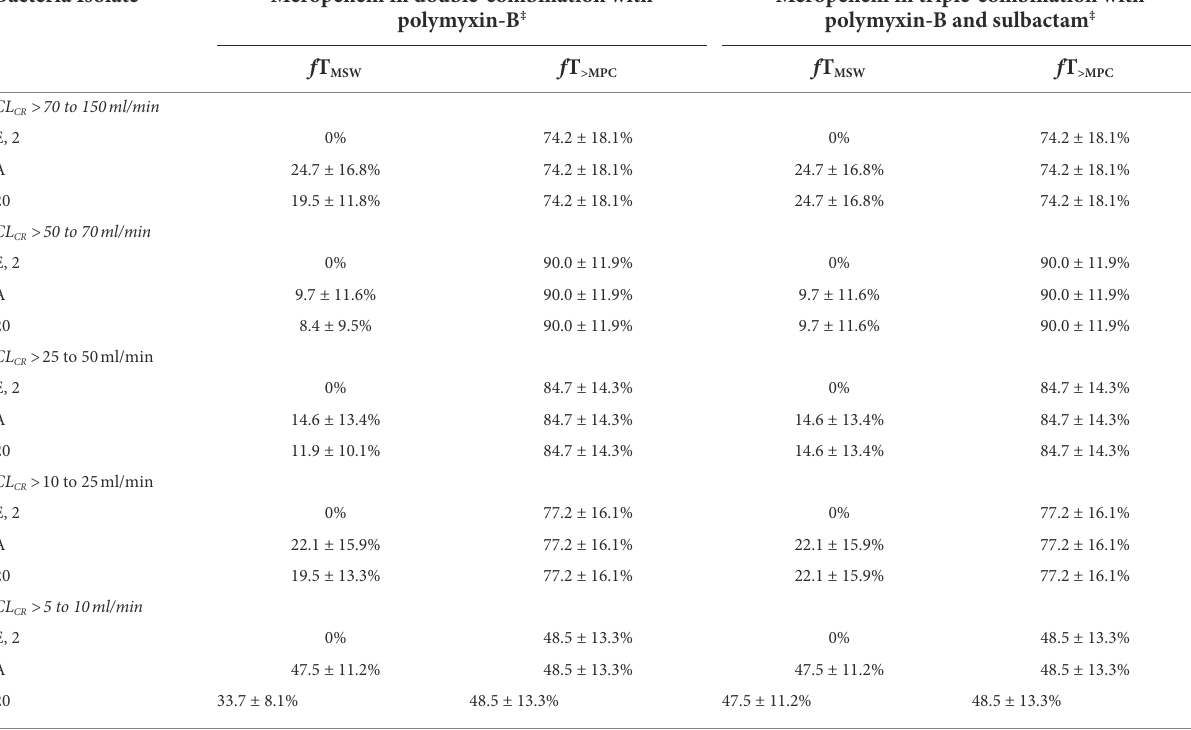
TABLE 7 Pharmacodynamic parameters f T MSW and f T >MPC based on MIC and MPC of meropenem in the epithelial lining fluid against four A. baumannii isolates harboring OXA-23 and other serine- β -lactamases. Bacteria